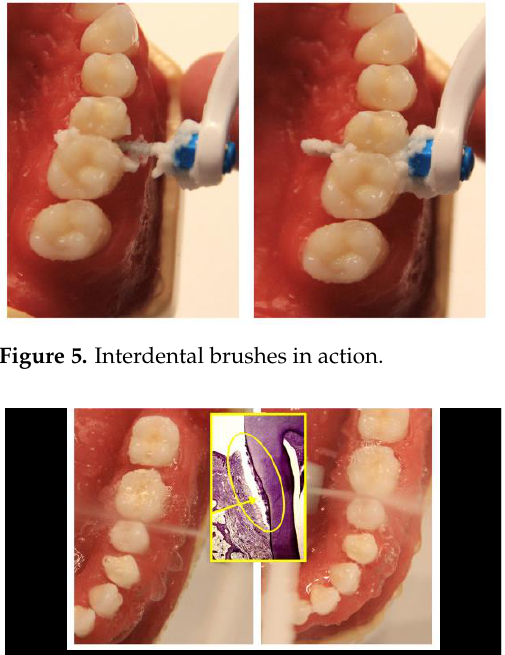
Figure 6. Oral irrigators in action, in order to remove sub-gingival biofilm.